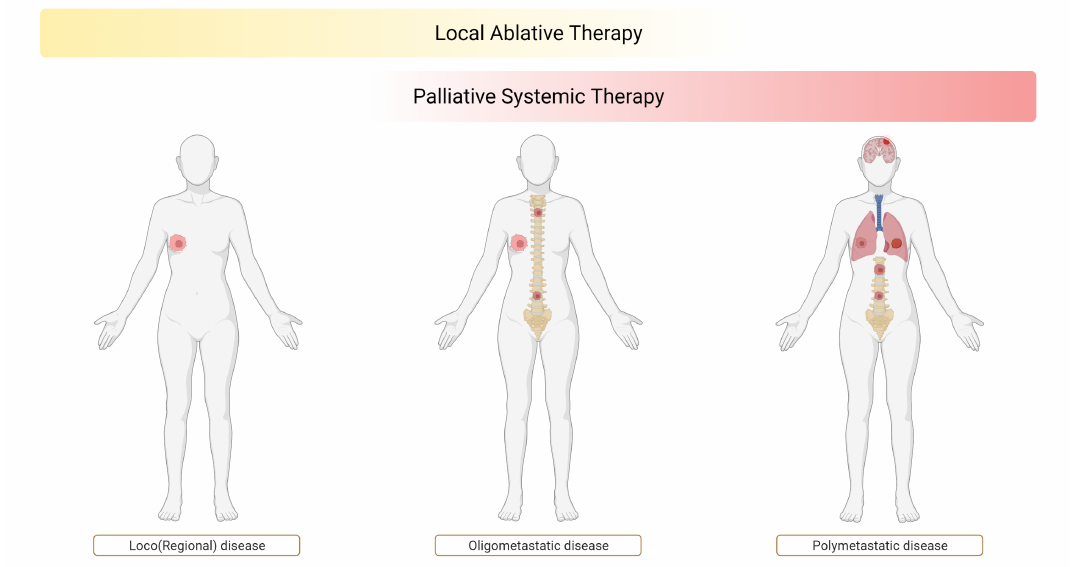
Figure 1. Oligometastatic state as an intermediate state between localized disease and widespread